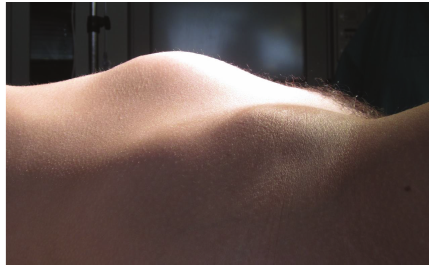
Figure 1: Clinical presentation of megahematocolpos.